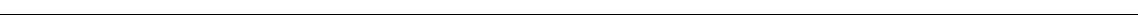
Fig. 5 Stereo-tuner dCas9 system. a Schematic overview of the system. An effector-less dCas9 is tagged with the auxin-inducible degron allowing inducible degradation upon addition of auxin. Two MS2 aptamer sequences are included in the single-guide RNA scaffold, as used in the Crispr/SAM system 8 . A transcriptional effector domain (e.g., VP64) is brought in by the MS2 aptamer-interacting MS2 core protein (MCP) which is fused to the ecDHFR destabilisation domain (ecDDD). Addition of the small molecule drug trimethoprim (TMP) improves the stability of naturally destabilised ecDHFR fusion proteins. PIC, Polymerase II initiation complex. b Western blot with HA antibody showing TMP concentration dependent stabilisation of the ecDHFR-MCP- VP64-5HA protein. β -actin antibody is included as loading control. c Dual-luciferase assay using a fi re fl y luciferase reporter driven from a minimal promoter with eight copies of a guide RNA target sequence (gRNA-1) in an effector-less AID-dCas9 expressing cell line. A ubiquitous Renilla luciferase construct was co-transfected as internal control. In the presence of the MS2 aptamer bearing gRNA-1, luciferase activity is produced by transfection of a dCas9-VP64 plasmid ( fi rst lane) or by the co-expression of the endogenous AID-dCas9 with the pecDHFR-MCP-VP64 effector module, and can be enhanced by TMP administration. Addition of auxin to the medium, affecting IAA17-dCas9 stability, abrogates luciferase activation. Grey columns, controls; Light blue column, no TMP, no auxin; Dark blue columns, TMP added; Red columns, auxin added. Error bars denote ± s.d. ( n = 3) (two-tailed t - test, (**) P <